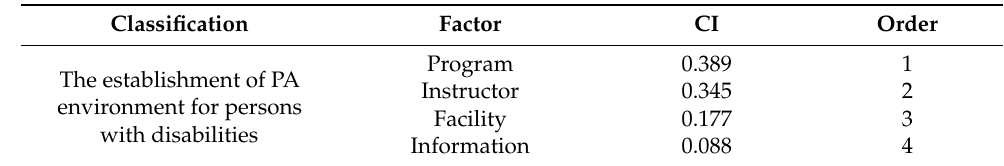
Table 2. Results of the relative importance of H2 for the establishment of the PA environment for persons with disabilities. Classification Factor CI Order